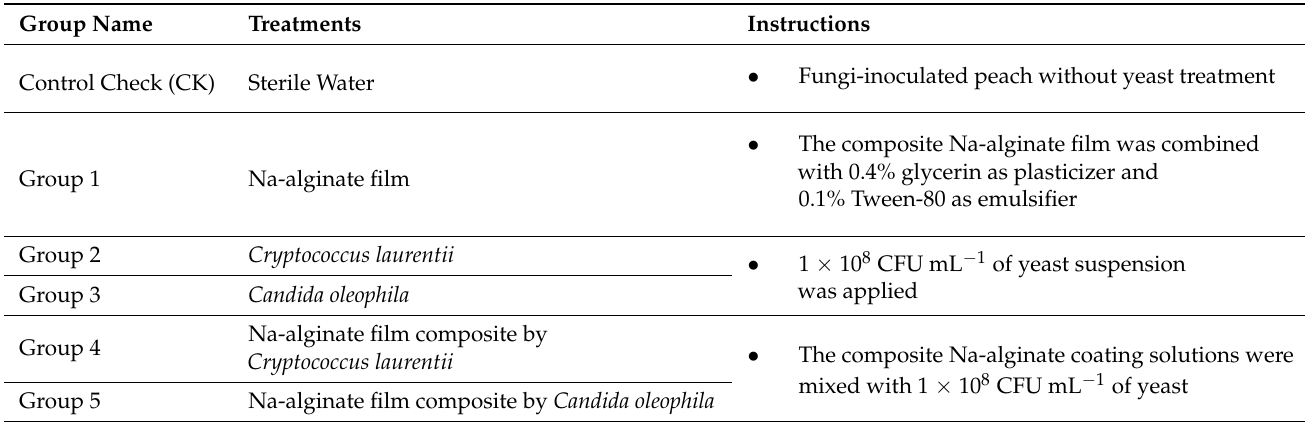
Table 1. Treatments of different